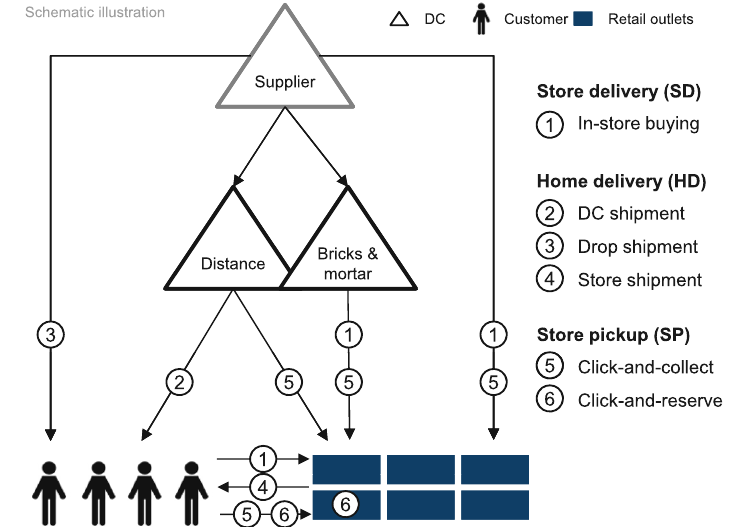
Fig. 2 Typology of omni-channel